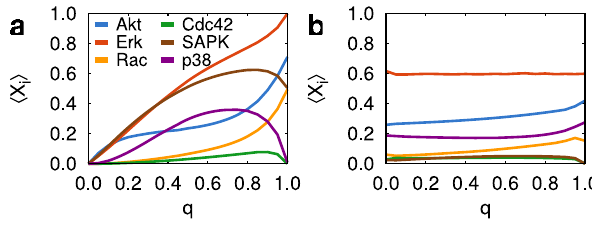
Figure 2. Temporal average of the population activity of the output nodes for increasing chatter levels. In these simulations, the activity of all input nodes is unstructured (i.e. the probability of the input nodes being active is set to a constant value q ). (a) Original network: the average activity of some output nodes increases monotonically, while it peaks at intermediate chatter levels for other outputs. (b) Randomized altered-logic network: the network activity is basically insensitive to chatter levels. In these randomized networks, the logic rules of the nodes are changed randomly (see Supporting Text S1 for details). The population activity was estimated from R ~ 201 cell realizations for each network. After dismissing a transitory period of 160 iterations [26], the temporal average of the population was